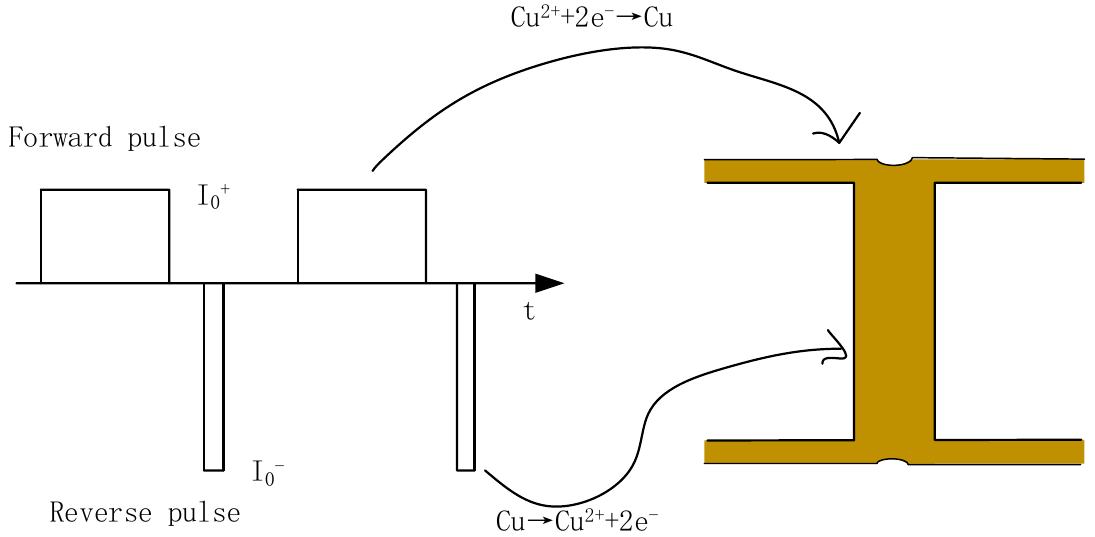
Figure 1. Principle of bidirectional pulse via-filling copper plating process.